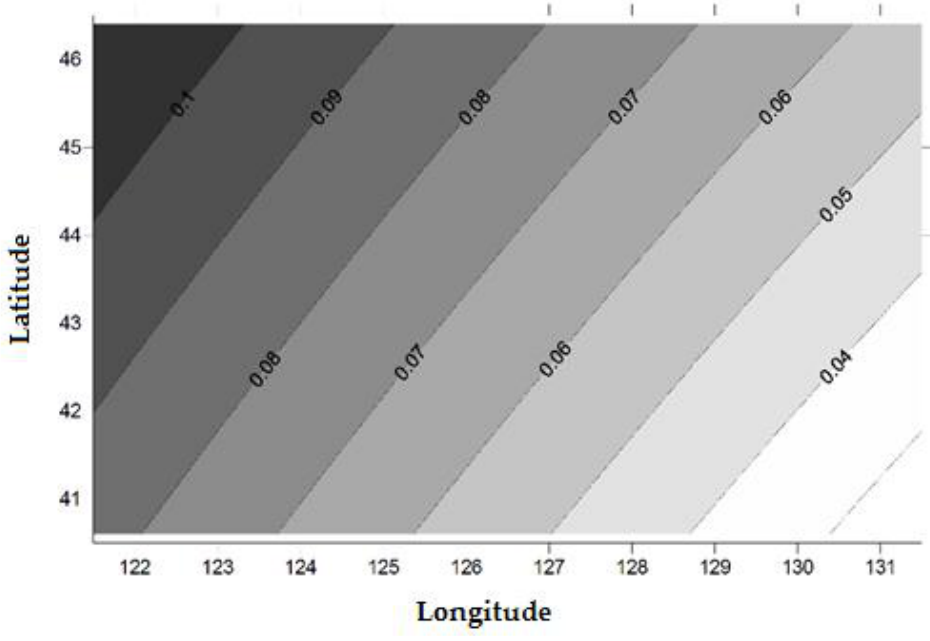
Figure 3. Ellipsoid datum difference between WGS84 and CGCS2000 in Jilin Province (m).